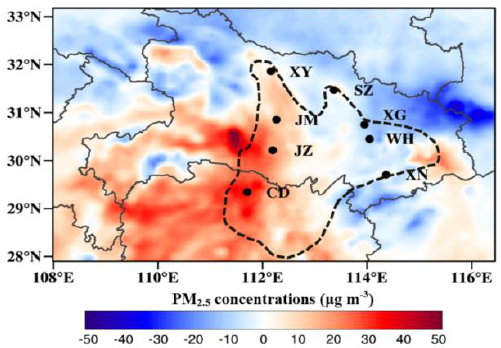
Figure 4. Distribution of near-surface PM 2.5 difference between real terrain and changed terrain simulations (CE and RHE, respectively).